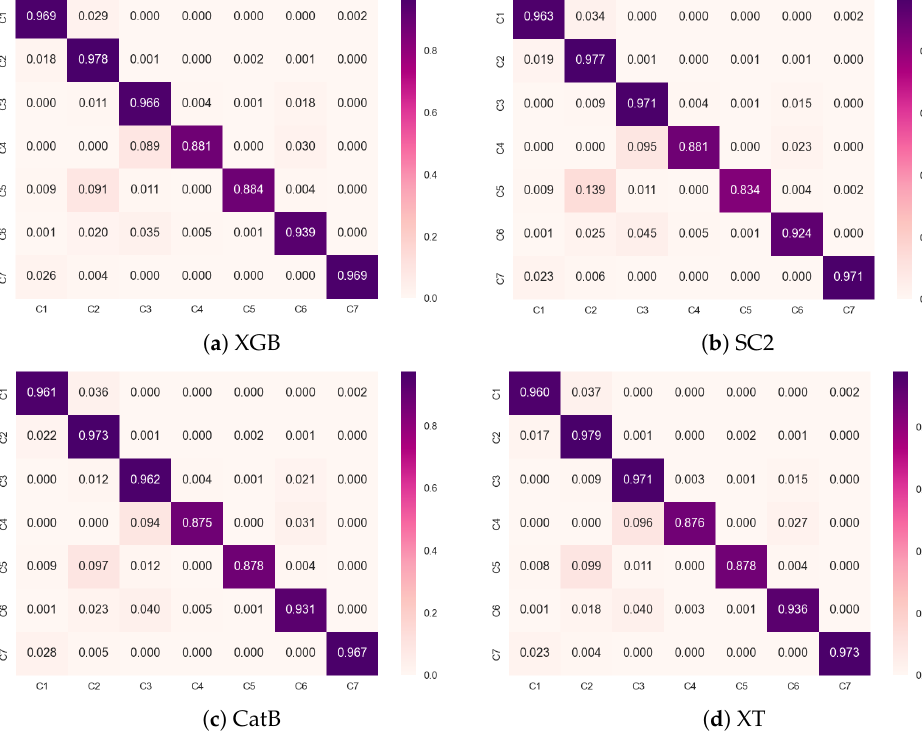
Figure 10. Confusion matrix of the four best-performing classifiers for predicted cover type